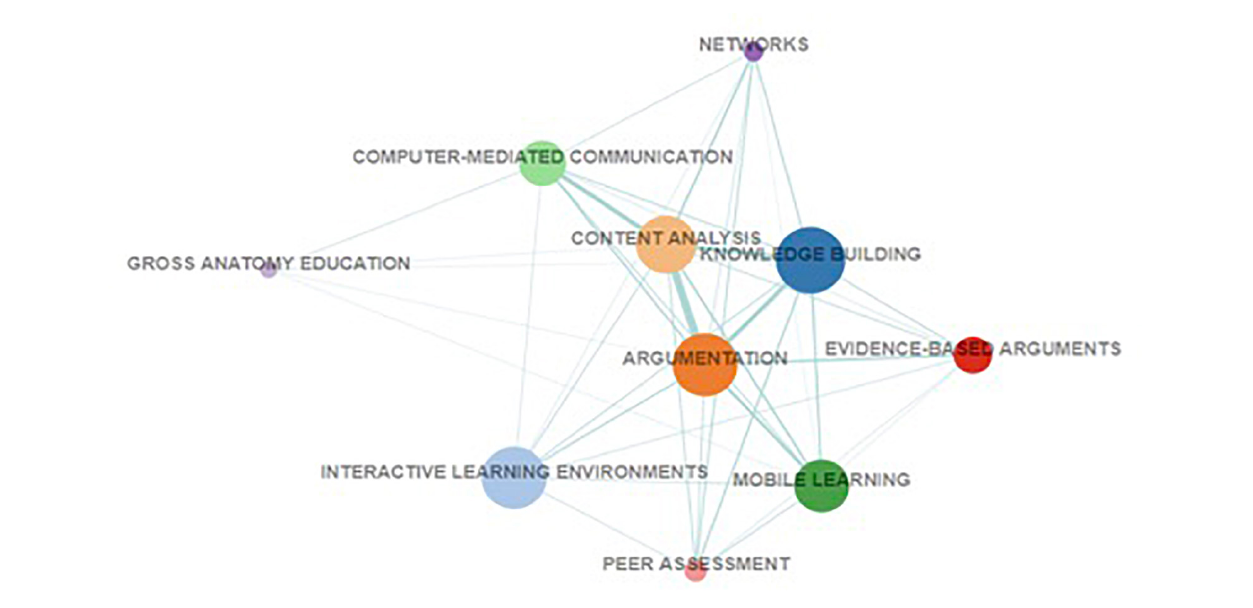
FIGURE 1 | Ten CSCL BC clusters (cluster labels represent most frequently used keywords by the articles in the clusters).